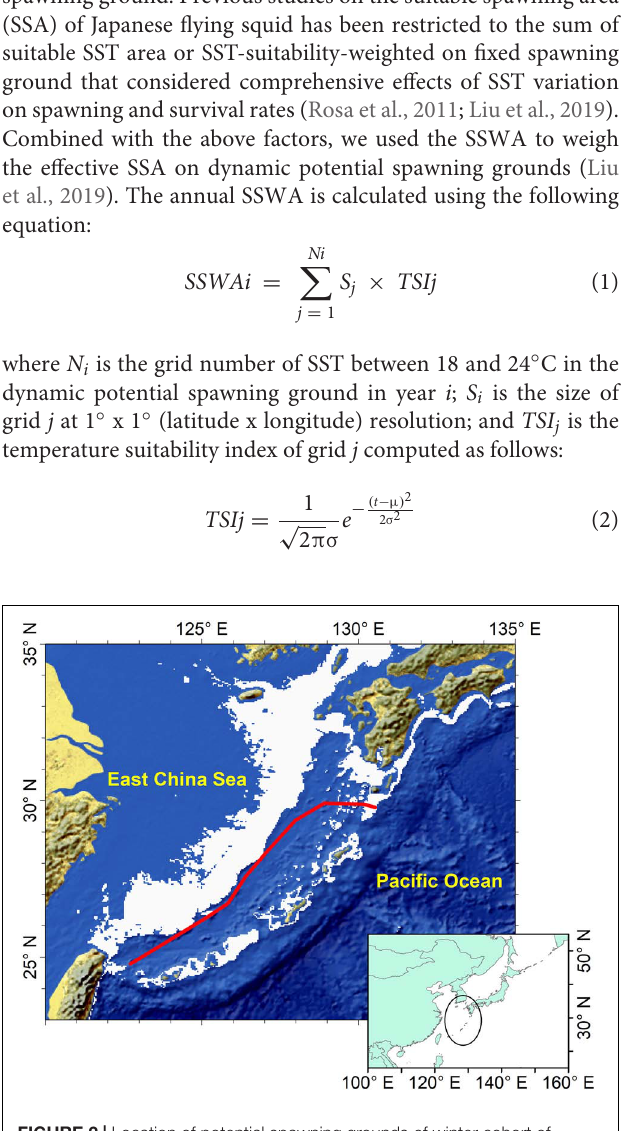
FIGURE 2 | Location of potential spawning grounds of winter cohort of Japanese flying squid. Red line represents the average position of the Kuroshio axis and the gray area represents regions with submarine elevation between 100 and 500